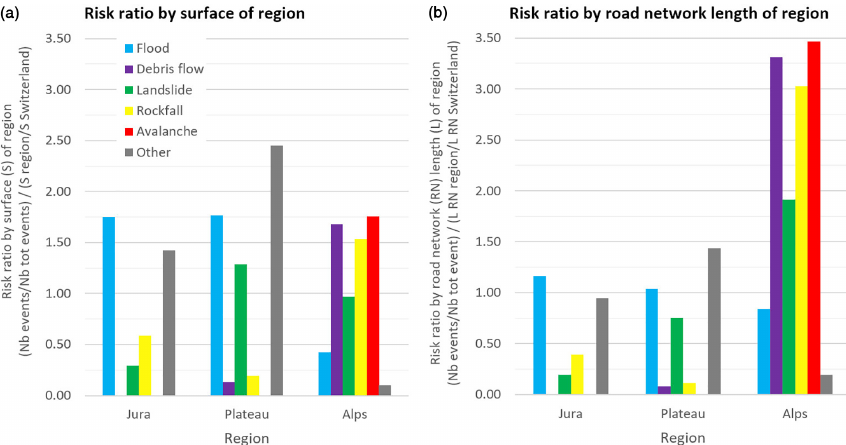
Figure 3. (a) Risk ratio by surface of the three geomorphologic–climatic Swiss regions. (b) Risk ratio by the road network (RN) length of the three geomorphologic–climatic Swiss regions.